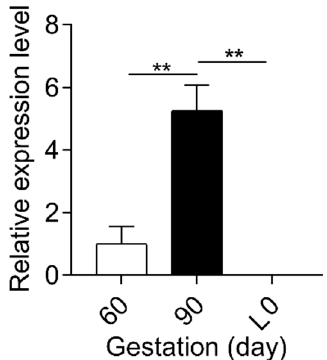
Figure 3. Relative expression levels of SULT2A1 in placentas at G60, G90, and L0, respectively. n = 3/group. Data are shown as means ± SE, ** p < 0.01.